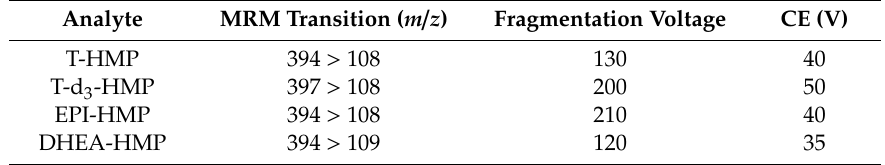
Table 2. Optimization MRM transitions of androgens and testosterone -d 3 derivative with